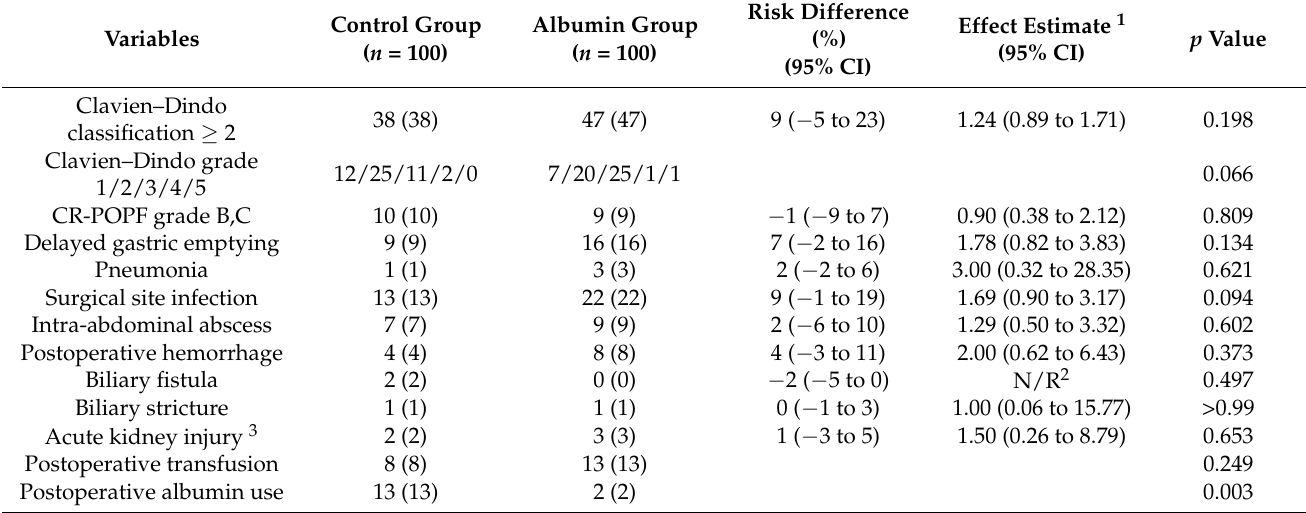
Table 2. Postoperative complications and outcomes after pancreatectomy.